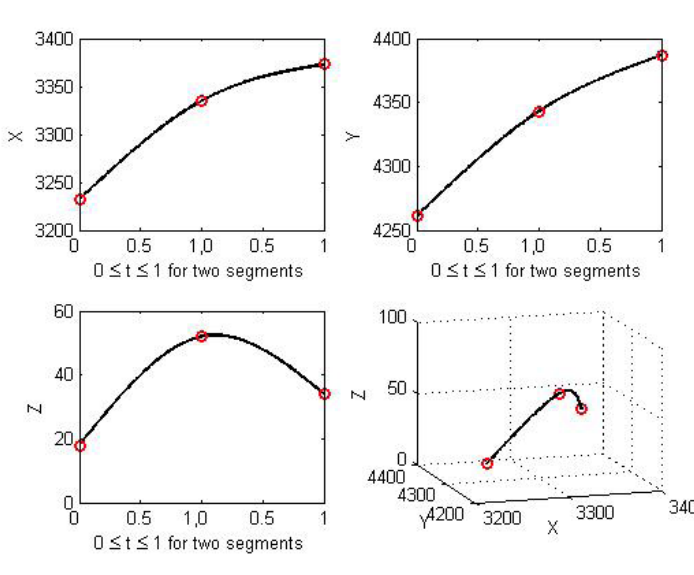
Figure 5. Natural cubic